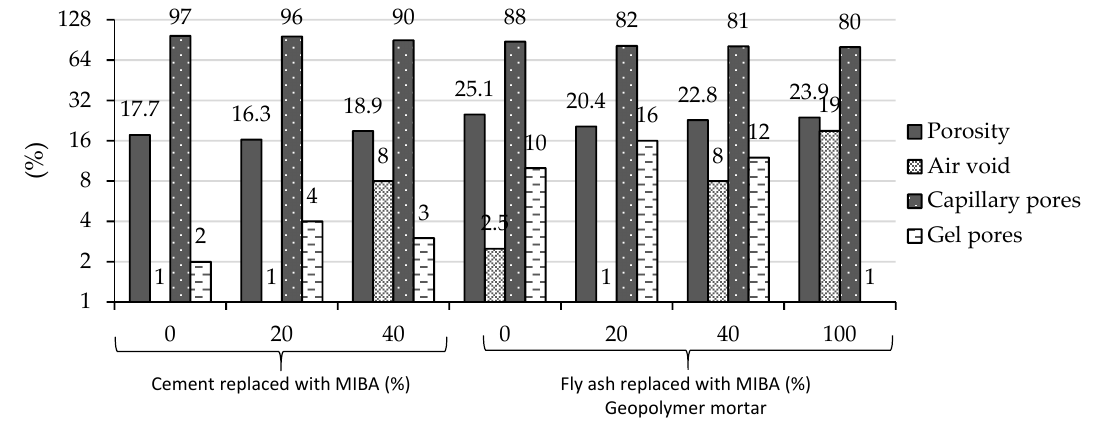
Figure 4. E ff ect of MIBA on the microstructure of cement and geopolymer mortar (adapted from Wongsa et al. [102]).